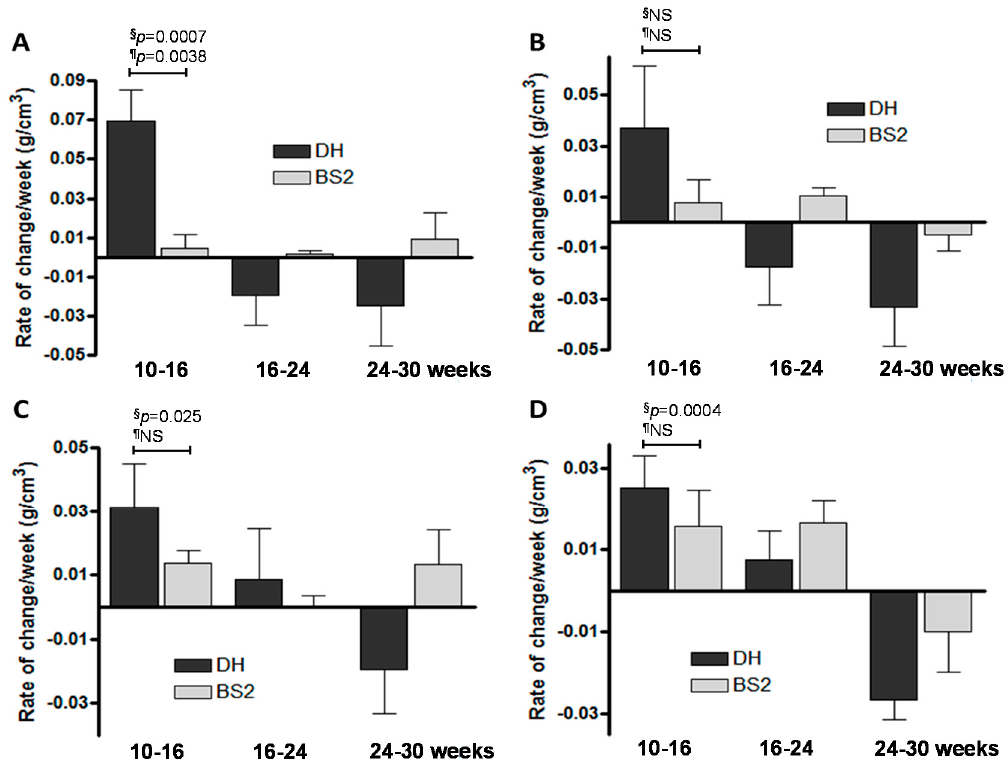
Figure 4. Rate of change in subchondral BMD of DH and BS2 guinea pigs for intervals 10–16, 16–24 and 24–30 weeks. ( A ) Medial Sbp BMD; ( B ) lateral Sbp BMD; ( C ) medial Tb BMD and ( D ) lateral Tb BMD. The rate of change in subchondral bone BMD between strains over time intervals were ranked and compared using 1 way ANOVA § and Student t -test ¶ . The p -values shown are for the earliest time point only.